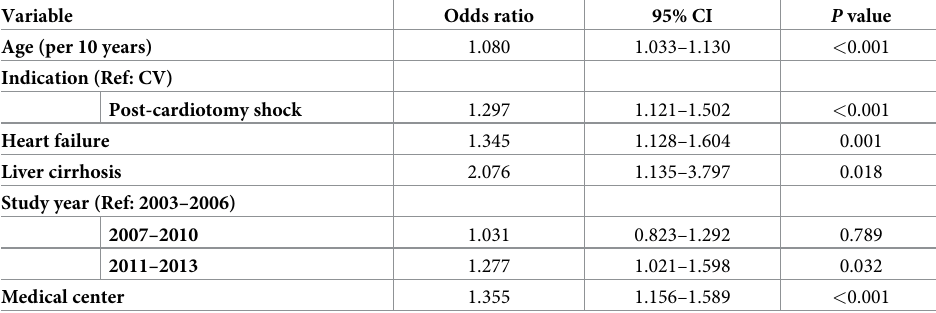
(Table 2). The following risk factors were significantly associated with the development of D-AKI: older age, medical center hospitalization, heart failure, liver cirrhosis, and ECMO indi- cation as postcardiotomy shock (Table 3). Table 3. Risk factor analysis of